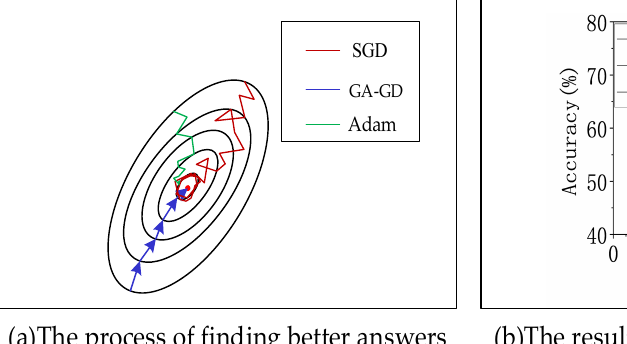
Figure 8. GA-GD test results.